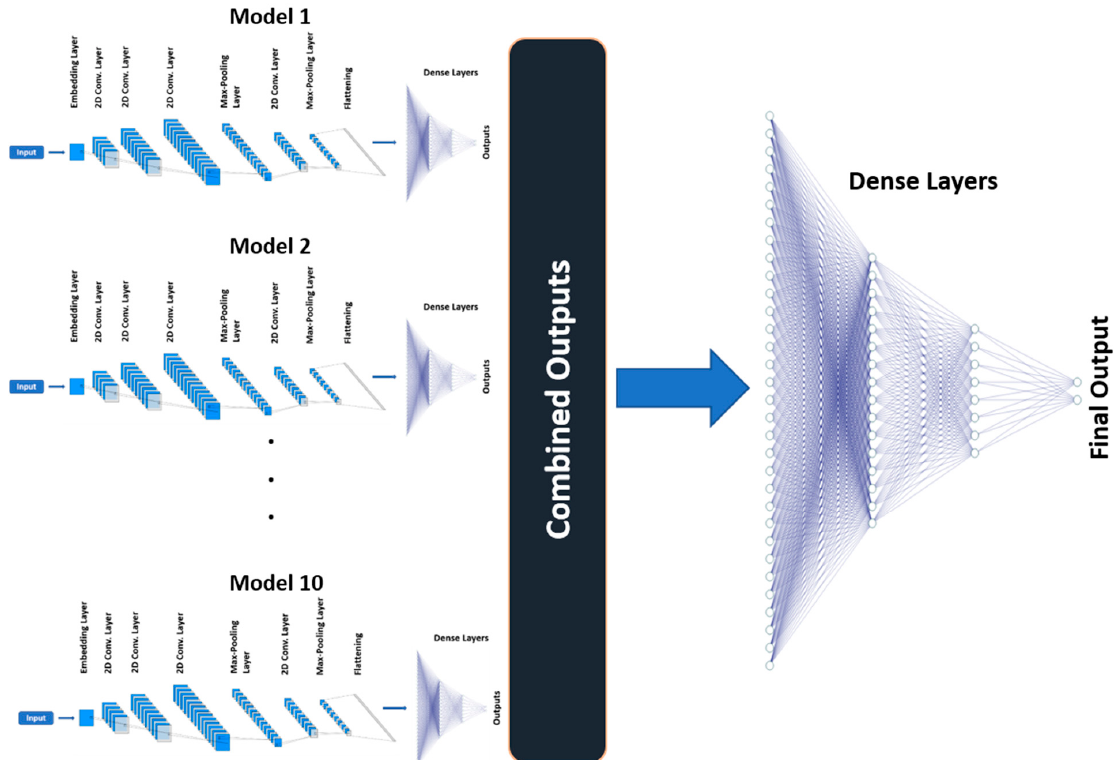
Figure 2. Stacking ensemble model combining 10 models from 10-fold cross-validation.